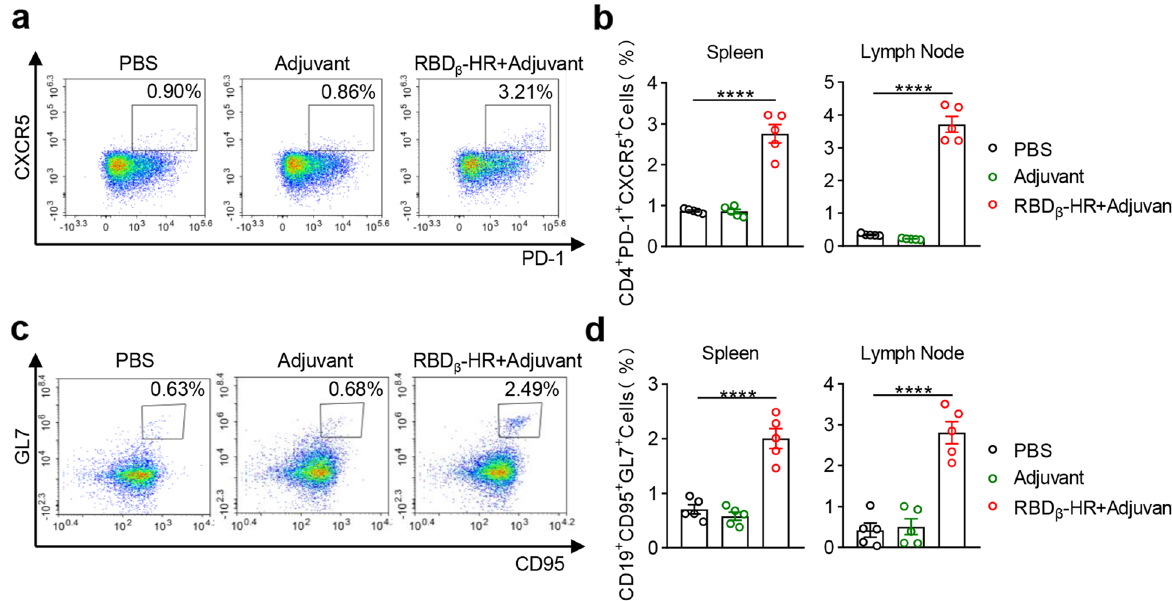
Fig. 6 RBD β -HR/trimer vaccine promotes the generation of Tfh cells and GC B cells. Mice immunized with PBS, MF59-like adjuvant, and RBD β -HR/ trimer vaccine were sacrificed on day 49. a Representative graphs of Tfh cells marked as CD4 + CXCR5 + PD-1 + . b The percentages of Tfh cells in the spleens and draining lymph nodes. c Representative graphs of GC B cells marked as CD3 − CD19 + GL7 + CD95 + . d The percentages of GC B cells in the spleens and draining lymph nodes. Data are mean SEM. p value < 0.05 were considered statistically significant (* p < 0.05; ** p < 0.01; ± *** p < 0.001; **** p <